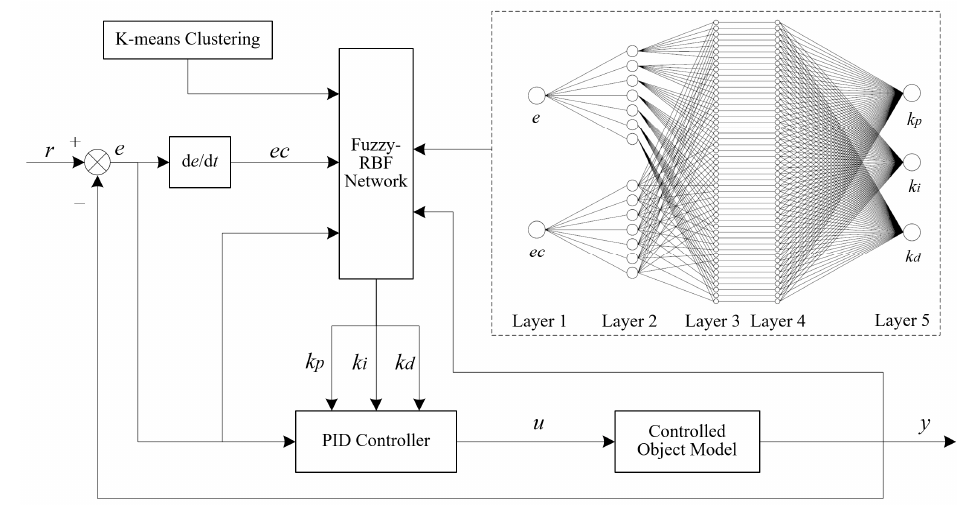
Figure 5. Structure diagram of the fuzzy neural network PID control system.